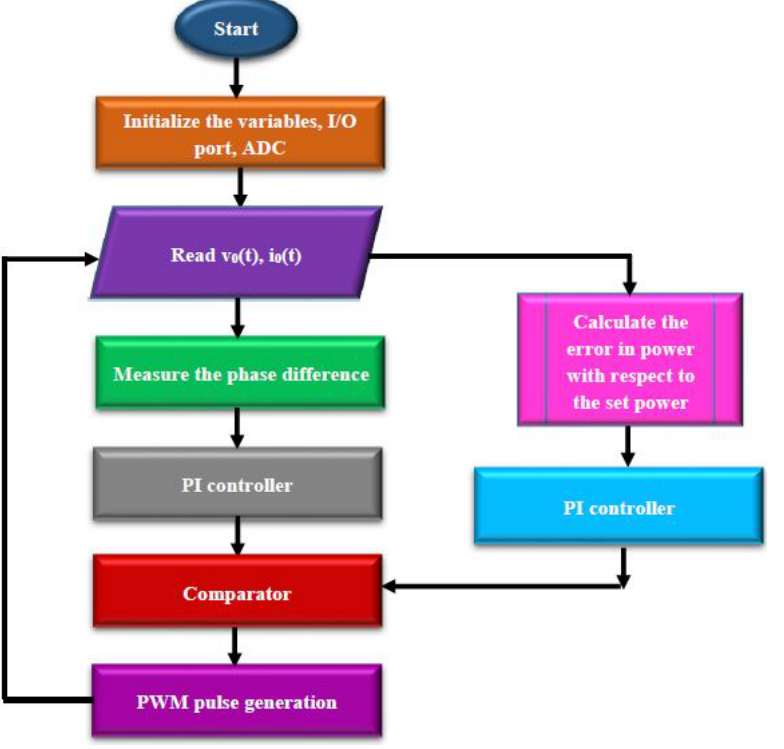
Figure 12. Flow chart of PLL-aided PWM control